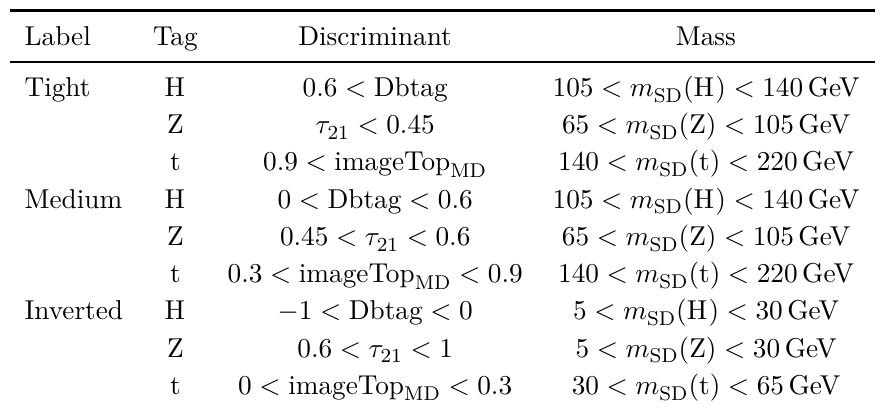
Table 1 . Selection regions used for signal identification and background estimation. The AK8 jet discriminant and mass selections are explicitly defined here for the t , Higgs, and Z jet tags.